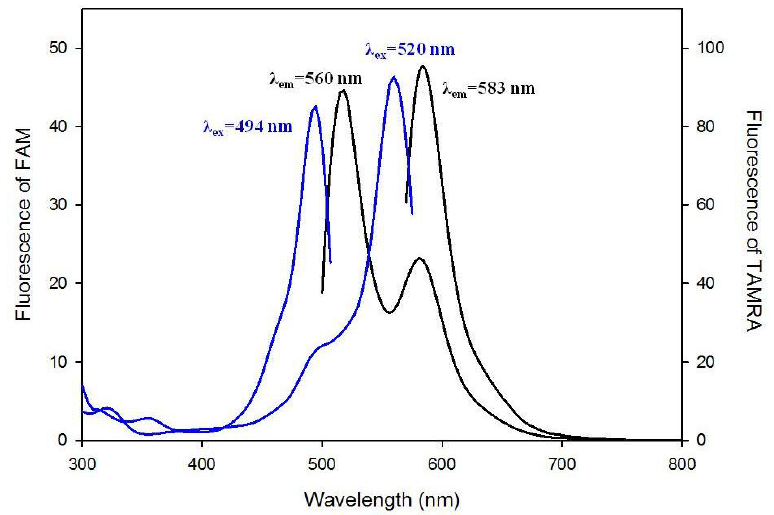
Figure 2. Fluorescence spectra for 0.2 μM F19T in cacodylate buffer (10 mM, pH